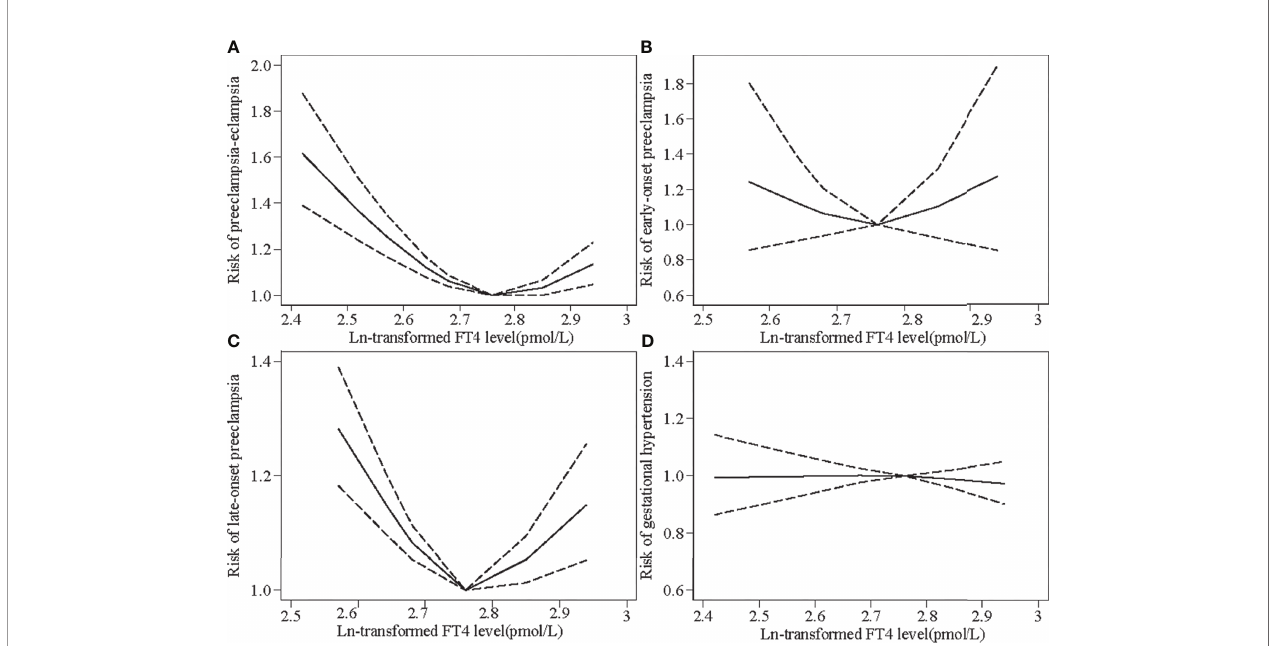
FIGURE 2 | Restricted cubic spline models for Ln-transformed free thyroxine (FT4) levels and the risks of preeclampsia – eclampsia (PEE) and gestational hypertension (GH). Knots were placed at the 25th, 50th, 75th, and 90th percentiles. The black line indicates risk ratios for PEE and GH; dashed gray lines are the 95% con fi dence intervals. (A) Ln-transformed FT4 levels and the risk of overall PEE. (B) Ln-transformed FT4 levels and the risk of early-onset preeclampsia. (C) Ln- transformed FT4 levels and the risk of late-onset preeclampsia. (D) Ln-transformed FT4 levels and the risk of GH.